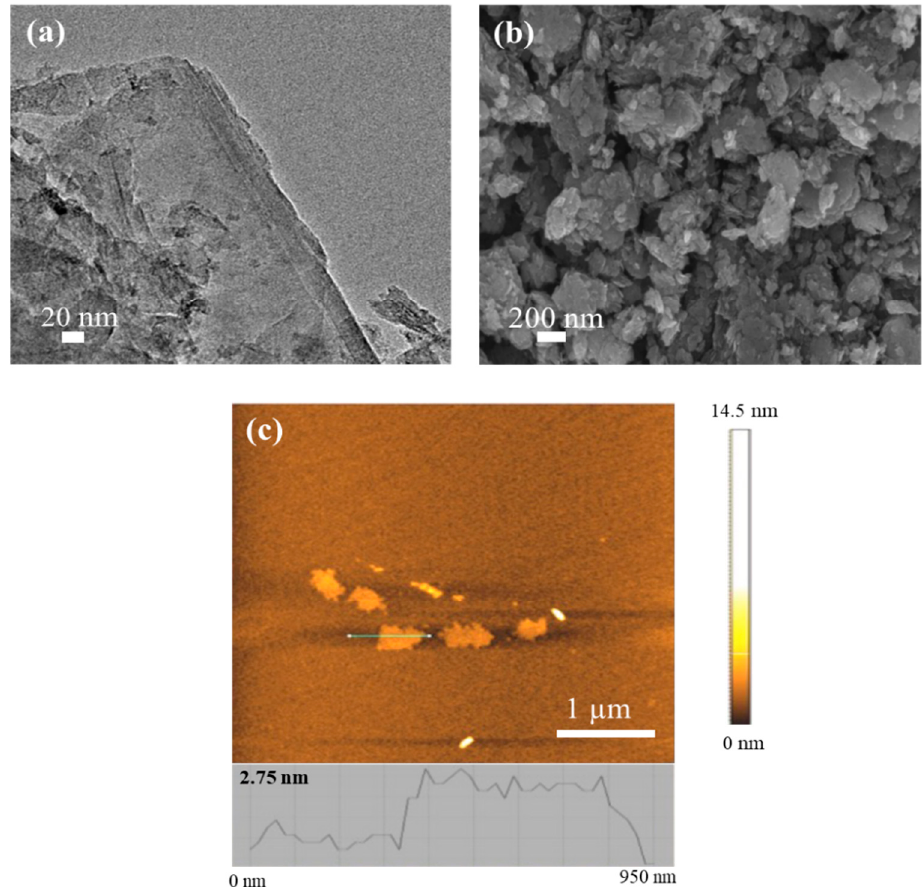
Figure 3. ( a ) Transmission electron microscopy (TEM) image of EOGO, ( b ) scanning electron microscopy (SEM) image of EOGO, and ( c ) atomic force microscopy (AFM) image and height profile of EOGO [24].